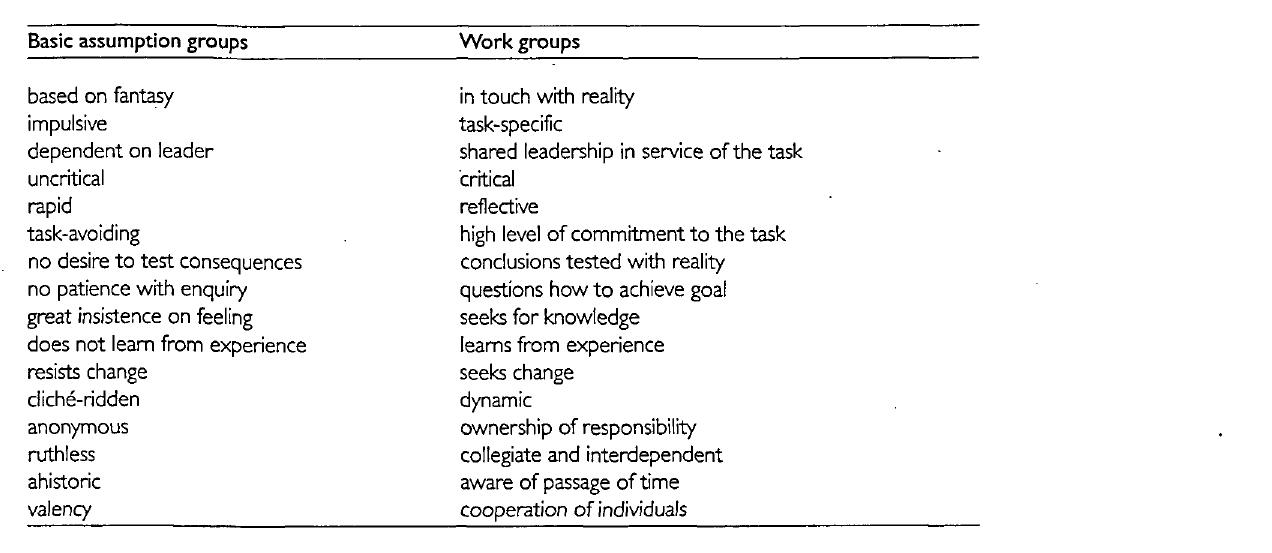
Table I: Distinguishing between basic assumption and work